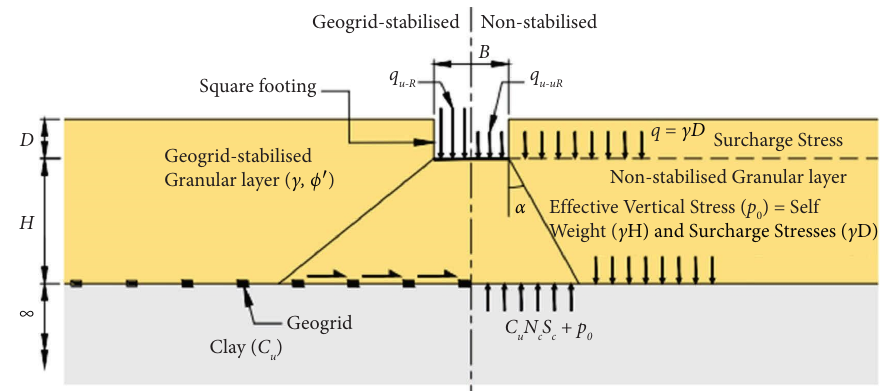
Figure 1: Schematic diagram and terminology of the